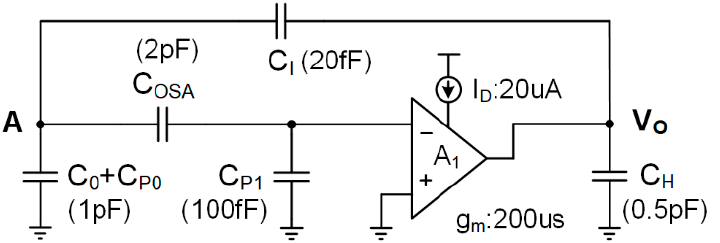
Figure 10. Equivalent circuit model with typical component parameters of CVC during signal amplification phase ( Φ 2 for conventional SC-CVC & Φ 3 for RNSF-CVC).